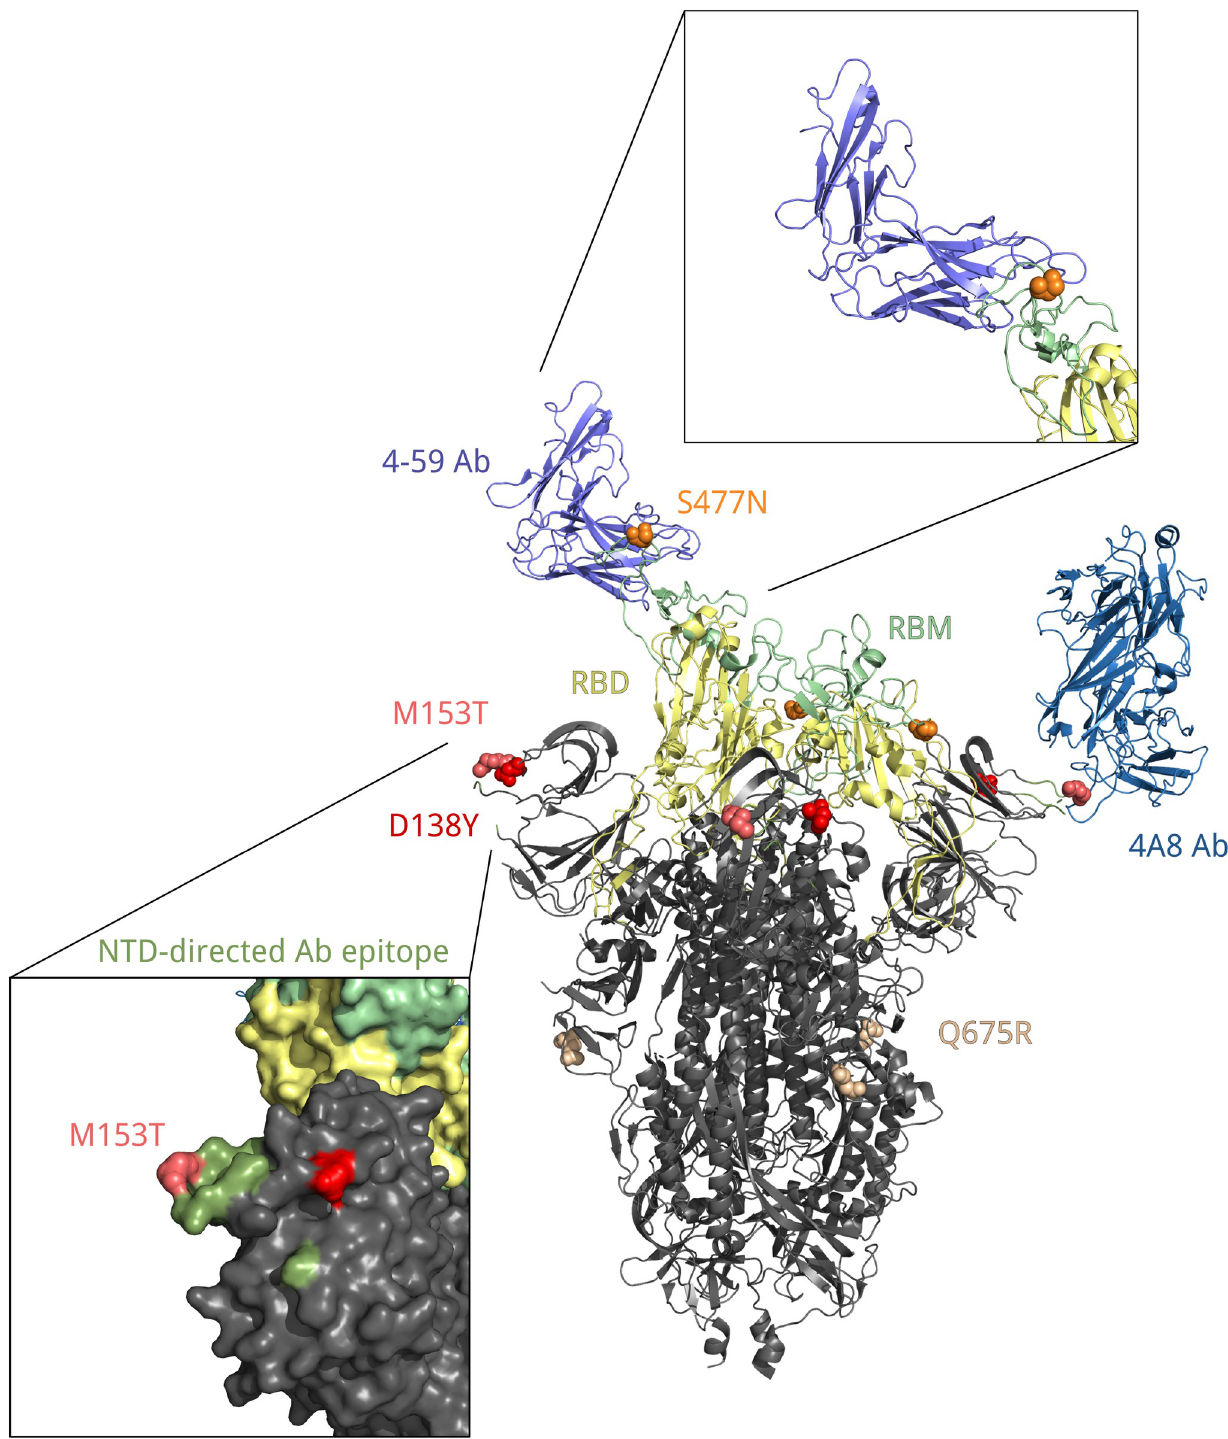
Fig 10. Position of residues 138, 153, 477 and 675 in the spatial structure of the S protein bound with 4A8 and 4–59 antibodies (PDB IDs: 7c2l and 7czx). Each of these residues is colored in its own color. Yellow, receptor binding domain; green, receptor binding motif; ocean blue, heavy chain of the 4A8 antibody; blue, heavy chain of the 4–59 antibody; olive, antibody binding epitope.